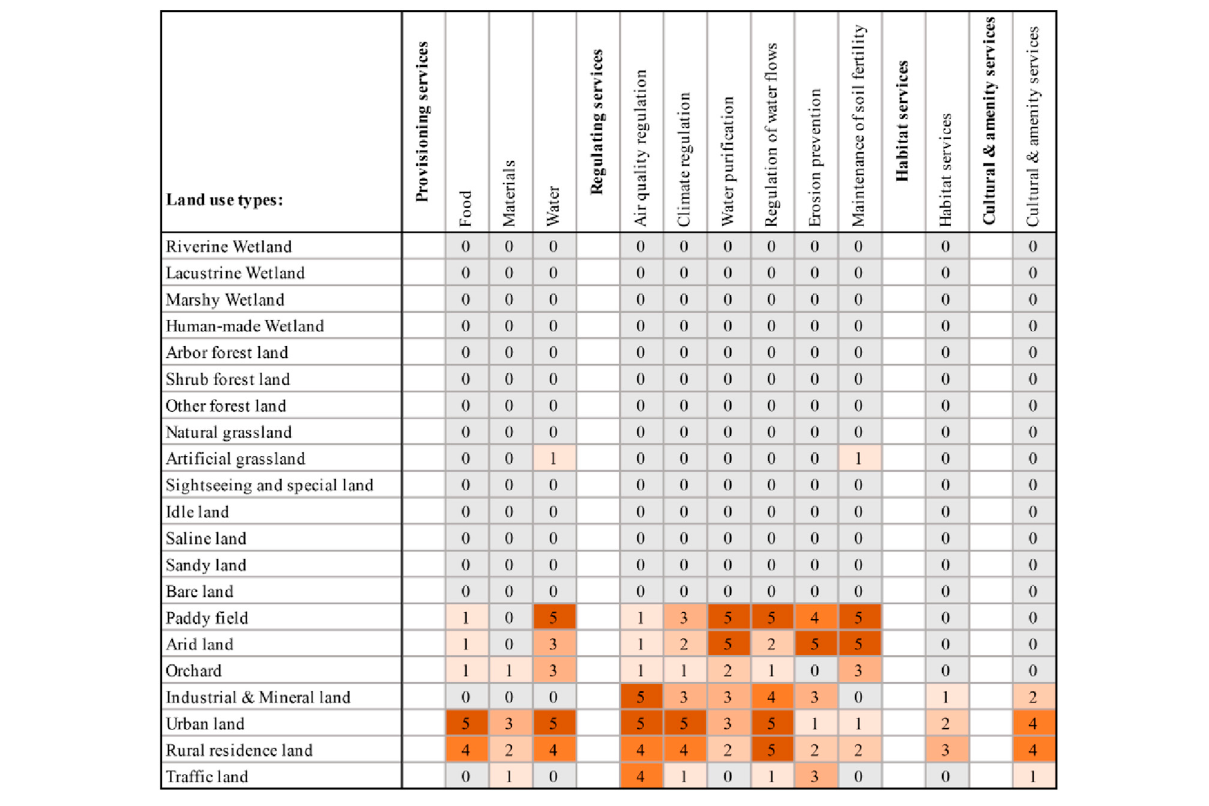
FIGURE 2 | Assessment matrix for the demand potential of ecosystem services within the different land use types. The values indicate the following potentialities: 0 (cid:1) norelevantpotentiality; 1 (cid:1) verylowrelevantpotentiality;2 (cid:1) lowrelevantpotentiality;3 (cid:1) mediumrelevantpotentiality;4 (cid:1) highrelevantpotentiality;and5 (cid:1) veryhigh relevant